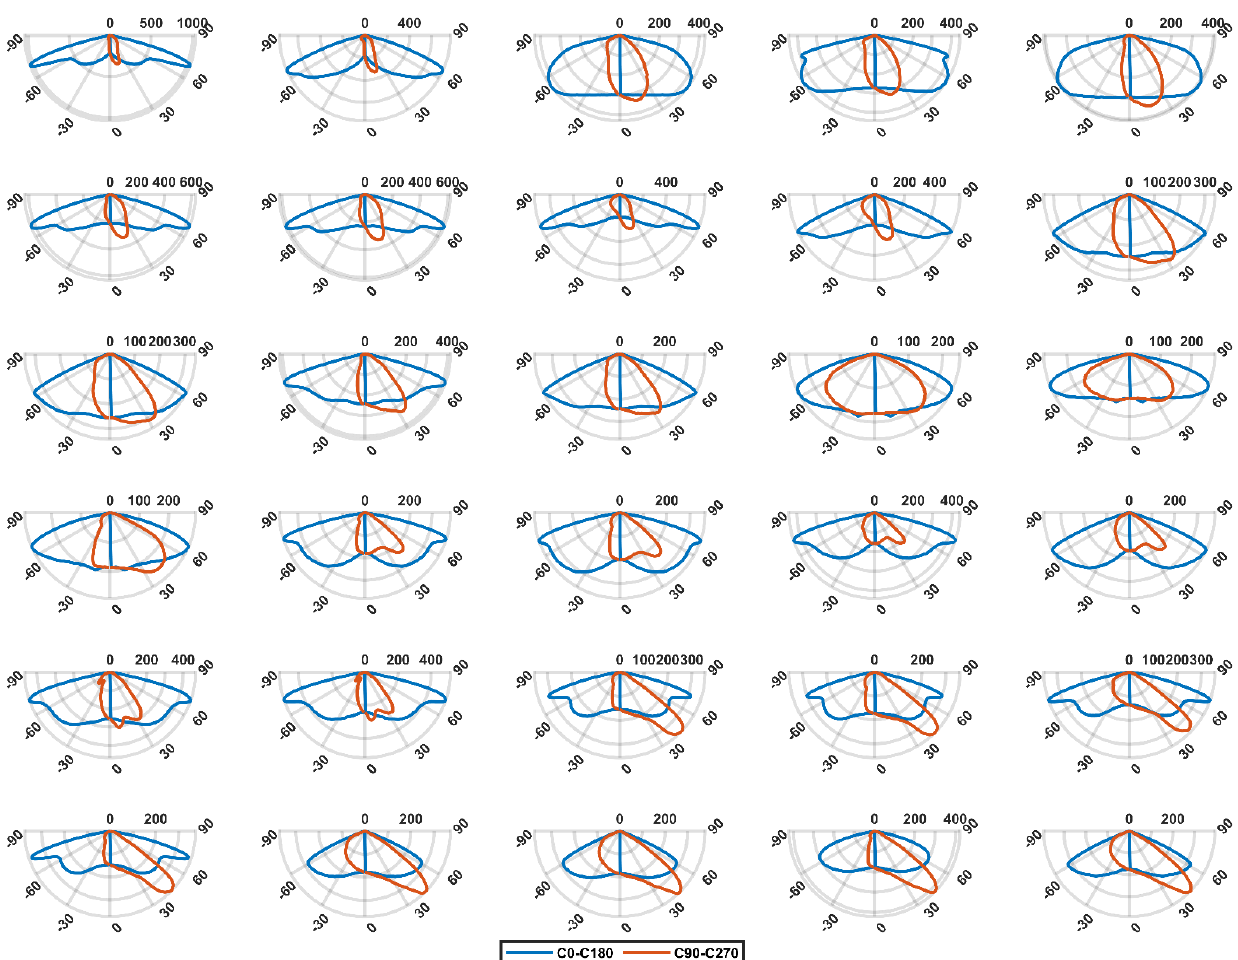
Figure 2. Luminous intensity distribution curves of a few representative luminaires (30 out of 150 used in total) in cd/klm. The key C–planes (C0–C180 and C90–C270) are shown for each luminaire.